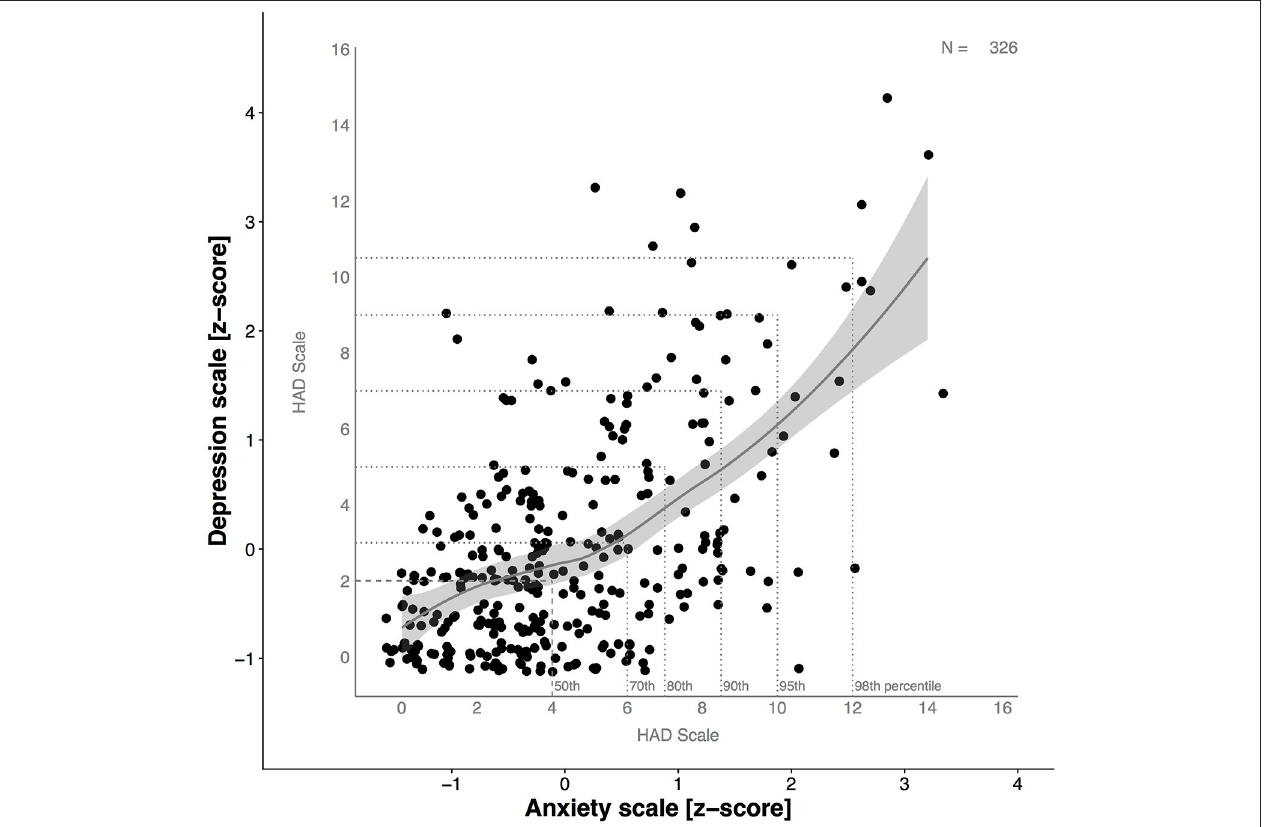
FIGURE 3 | Relationship between anxiety and depression and expression as Z-scores. Line of best fit with 95% CI as highlighted in gray. Z-scores above “0” indicate higher values on the HAD Scale-subscale compared to the sample mean. Z-score values below “0” indicate lower values on the HAD Scale-subscale compared to the sample mean. Z -values above + 1.96 were considered as relevant for diagnostic purposes. Please note: the graphic shows a slightly greater increase in anxiety than